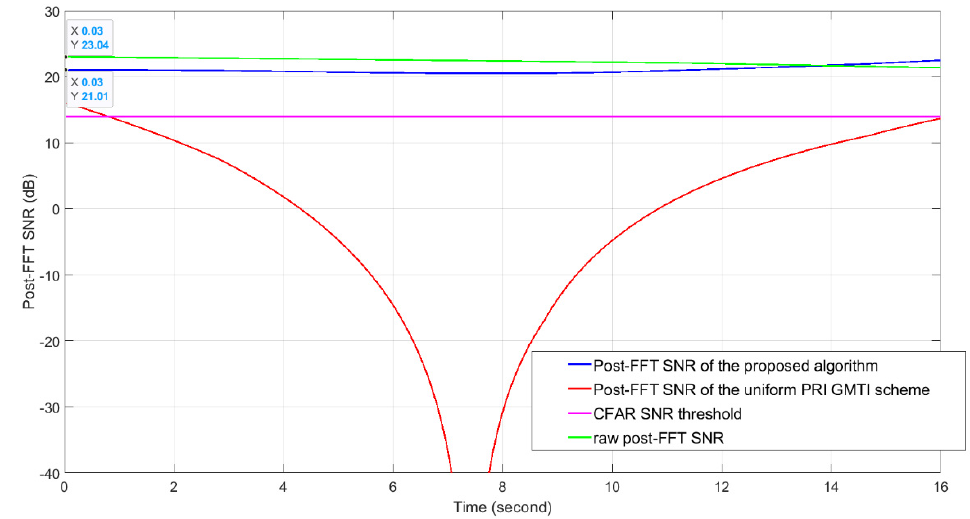
Figure 11. The post-FFT signal to noise ratios (SNRs) vs. time. These data sets are calculated based on the 4 × 4 AESA mainlobe gain of 12.04 dBi and 4 × 4 DPA mainlobe gain of 12.04 dBi.